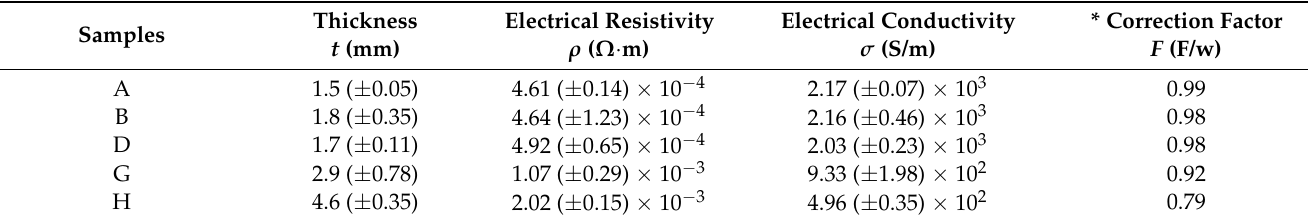
* The correction factor was calculated from Table 3 in Ref. [14].